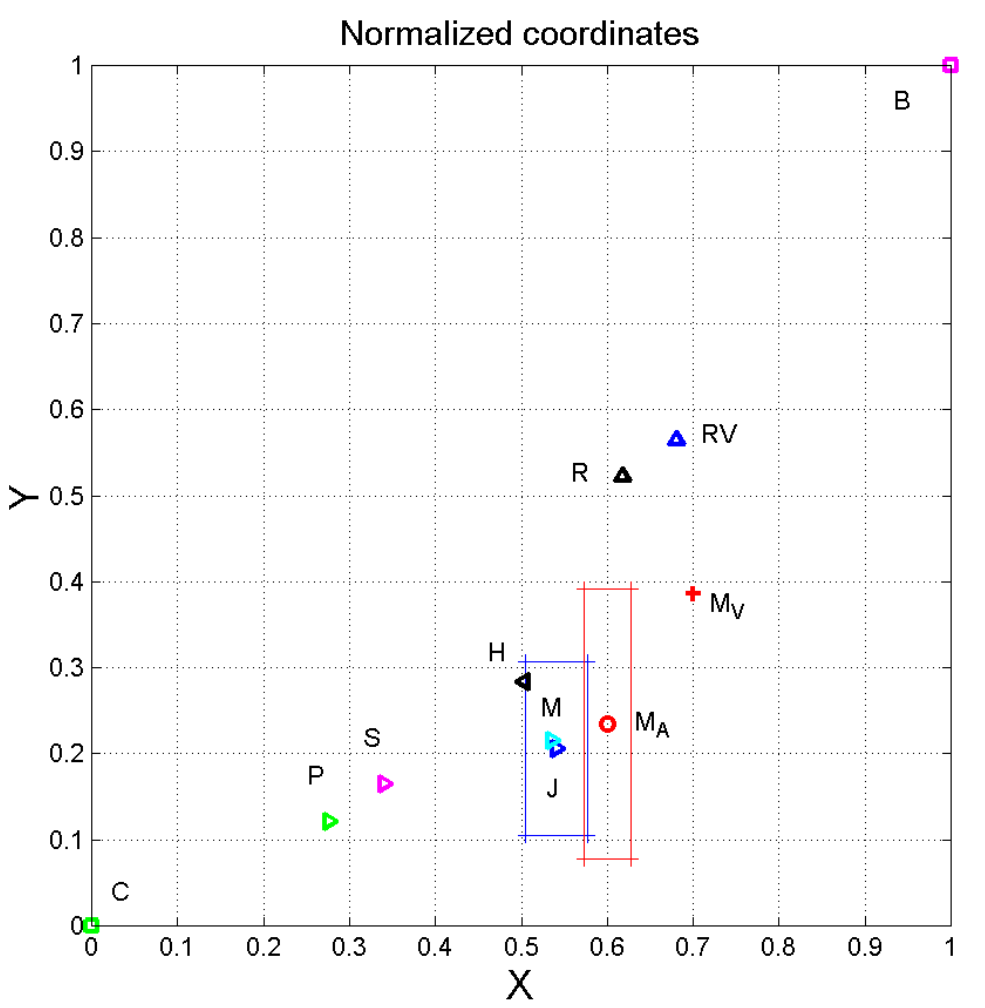
Figure 6. Coordinates x and y of the resulting vector (5) of a literary work, with reference (normalized) to the coordinates of the Boccaccio and Cassola, by assuming Cassola’s La Ragazza di Bube as the origin, coordinates (0, 0), C, and Boccaccio’s Decameron located at (1, 1), B (see [3,12]; in [3] the coincidence of M and J is fully discussed). P: Parables ; S: Jesus’ Sermons and Speeches ; J: Jesus says ;